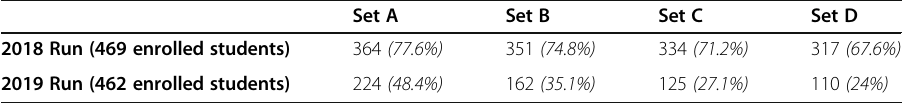
Table 4 Participation in each IGSS grammar set per run (no. of students and percentage